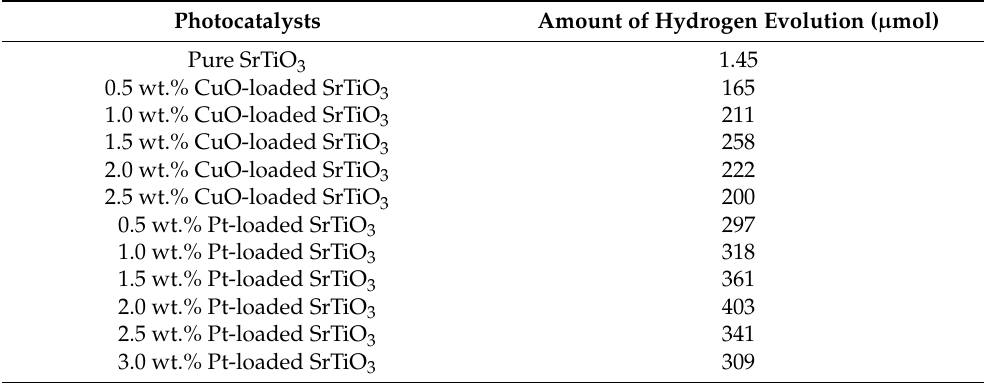
Figure 4. The effects of the loading amount of CuO ( a ) and Pt ( b ) on the photocatalytic hydrogen evolution activity of SrTiO 3 (catalyst: 60 mg; methanol content: 60 mL, 60 vol.%; reaction temperature: 25 °C). Table 1. The photocatalytic hydrogen evolution over various photocatalysts (photocatalyst: 60 mg; the content of methanol: 60 mL, 60 vol.%; temperature: 25 °C; irradiation time: 2 h).